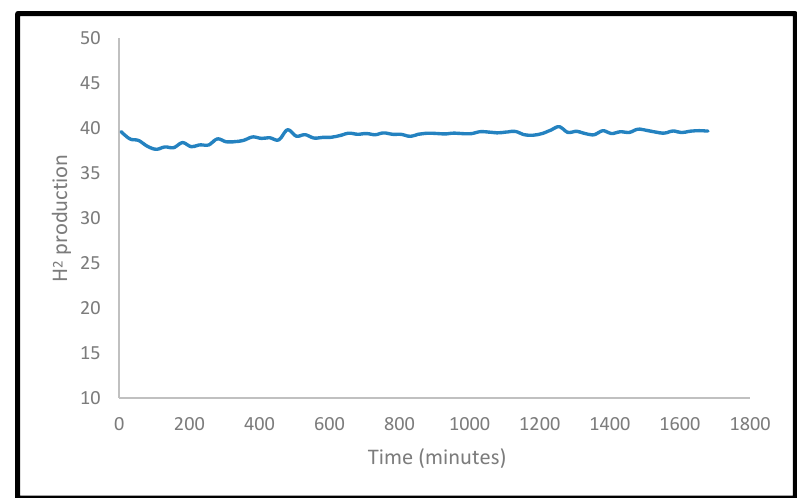
Figure 12. H 2 Selectivity of Ni,Pd,Pt/Mg 0.85 Ce 4+0.15 O catalysts with a temperature of 900 °C, GHSV = 15,000 mL h − 1 g − 1 cat., and CH 4 / CO 2 ratio of 1:1. atmospheric pressure.